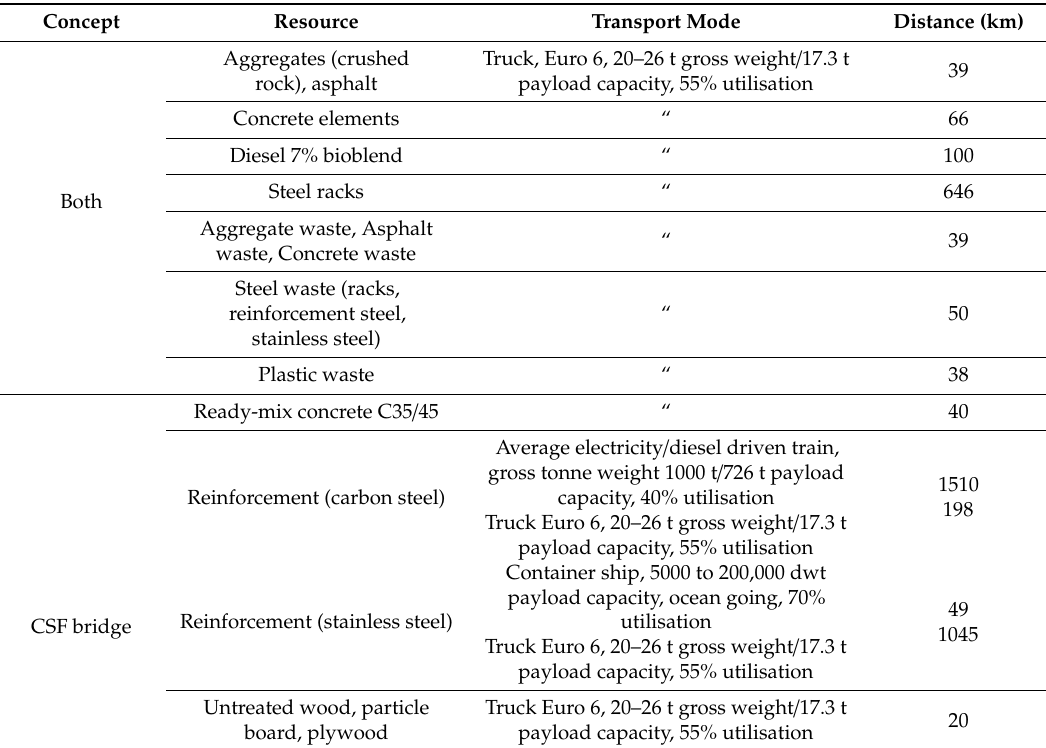
Table A6. Transport modes and distances travelled for the resources (applicable for modules A4, A5, B1–B4 and